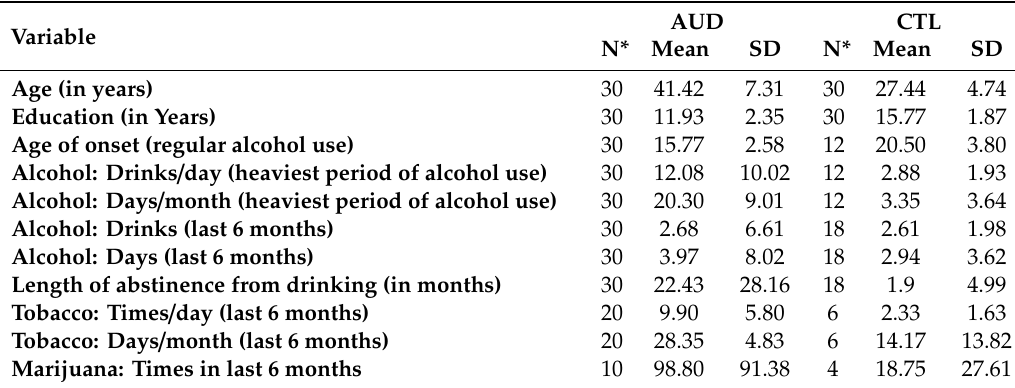
Table 1. Demographic and clinical characteristics of the sample. Sample size (N), mean, and standard deviation (SD) are